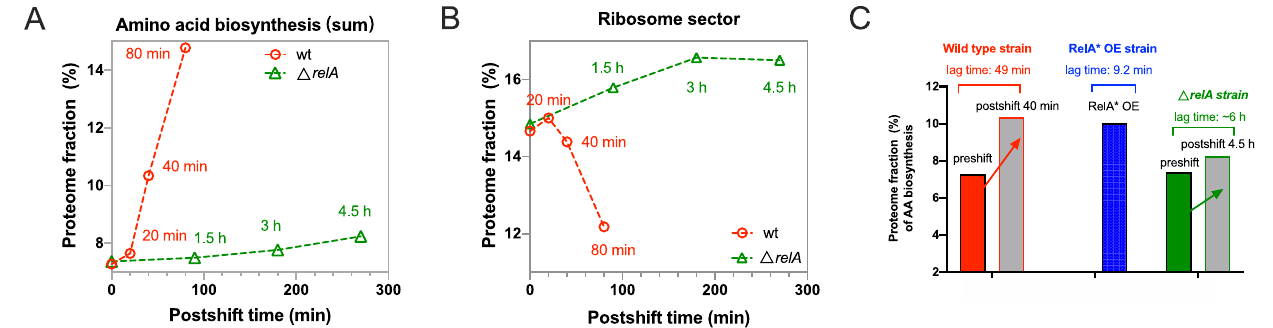
Fig.4|Dynamicchangeintheabundancesofaminoacidbiosyntheticproteins during amino acid (AA) downshift. Wild type and relA -de fi cient E. coli strains undergo transition from glucose cAA medium to glucose minimal medium as showninFig. 1C, D. The proteomes of wild type cells at0min, 20min, 40min, and 80min of postshift were analyzed while the proteomes of relA -de fi cient strain at 0min, 1.5h, 3h, and 4.5h of postshift were analyzed. A Dynamic change in the